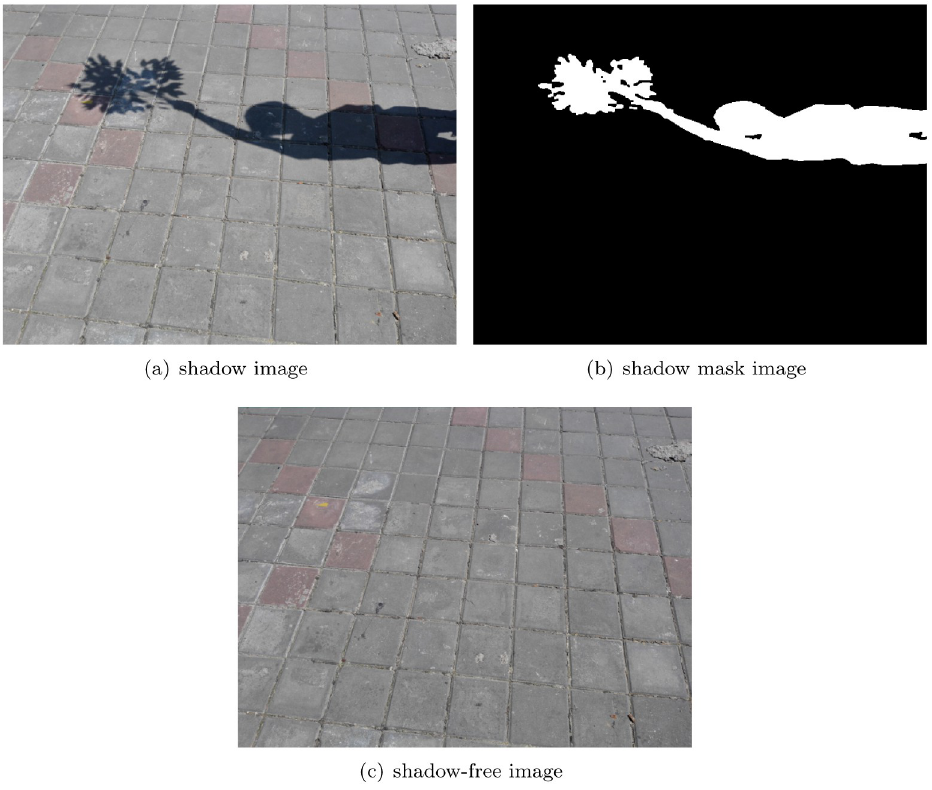
Fig 1. Images of one triplet in ISTD dataset. (a) shadow image. (b) shadow mask image. (c) shadow-free image.